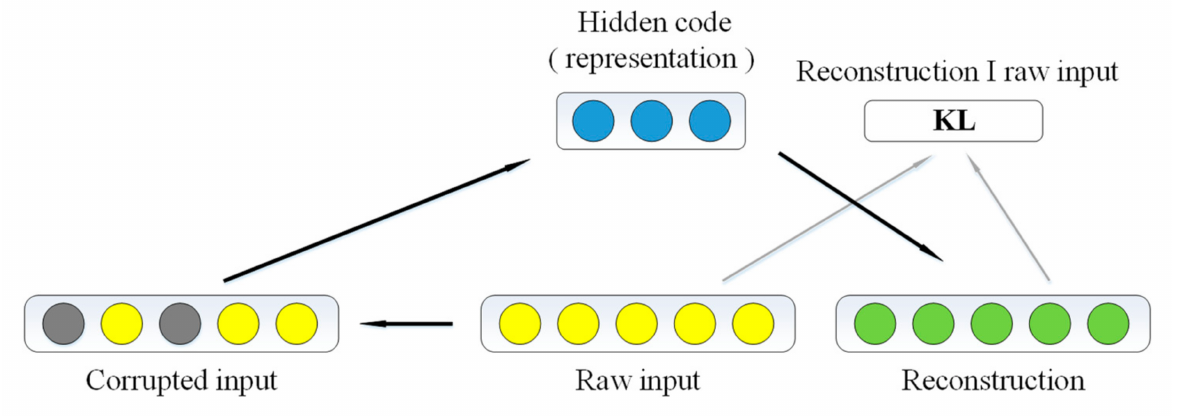
Figure 5. The architecture of denoising